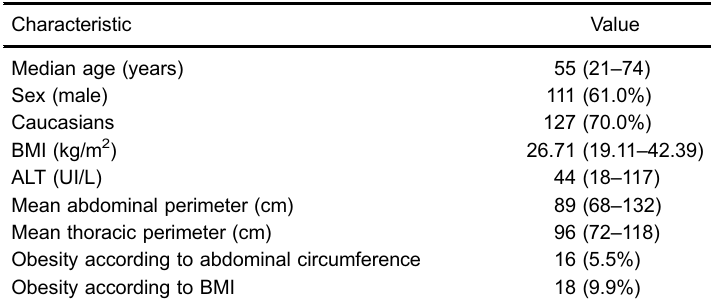
Table 1. Baseline characteristics of the 182 patients included in the